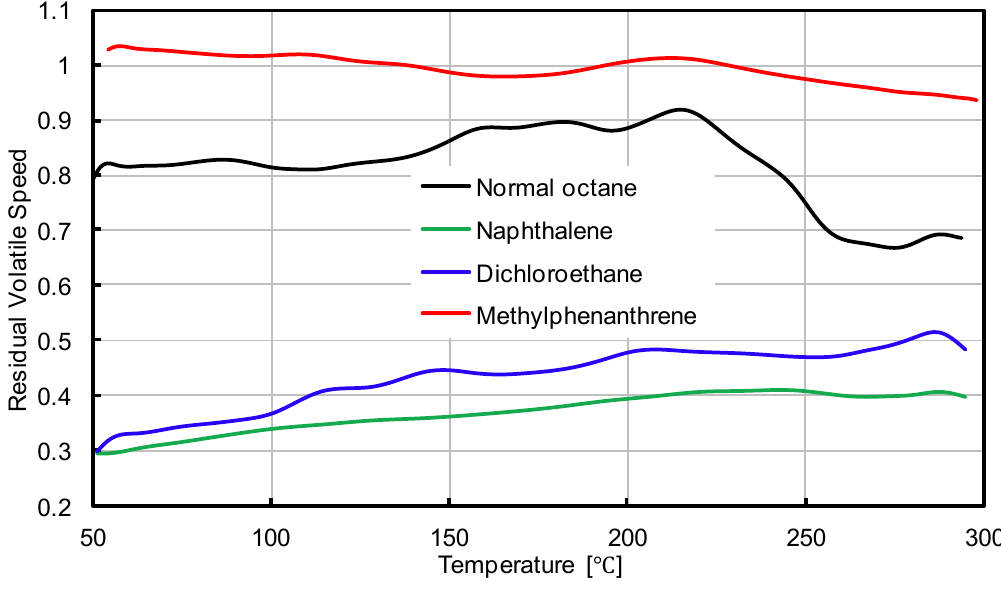
Figure 6. Residual volatile speeds of four types of gas.